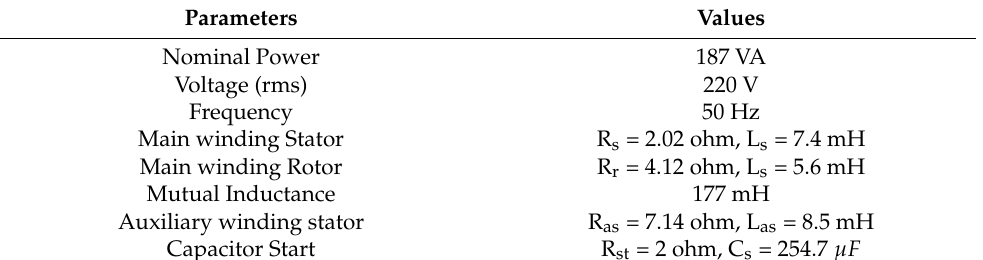
Table 2. Simulation Parameters of inductive Load.